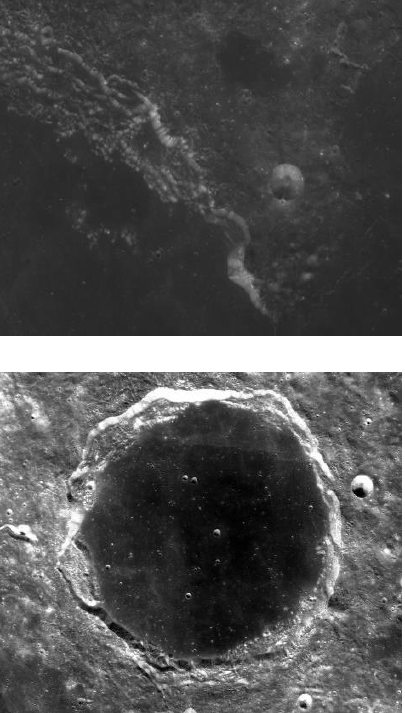
Figure 4. CE-2 DOM of the tail of Montes Jura southeast (up) and Crater Plato